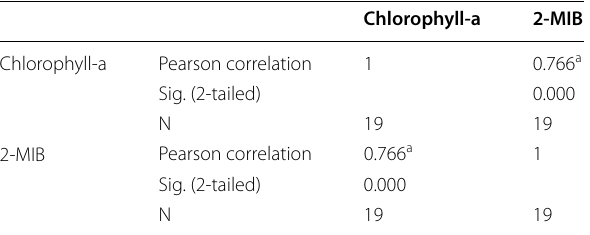
Table 6 Correlation analysis of chlorophyll-a and 2-MIB of SY after data selected